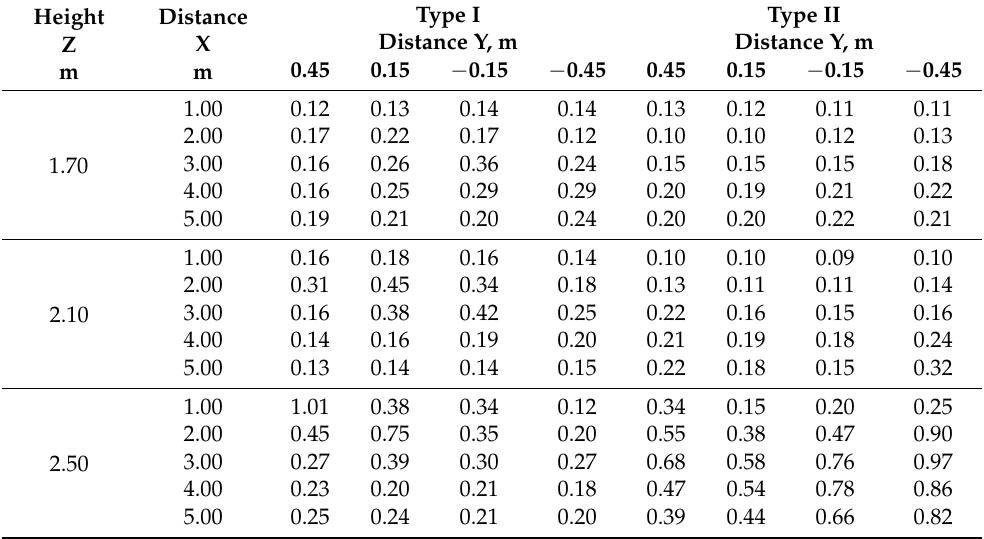
Table 2. Results of the measurements for velocity of the air flowing out of the supply air diffuser Type I and Type